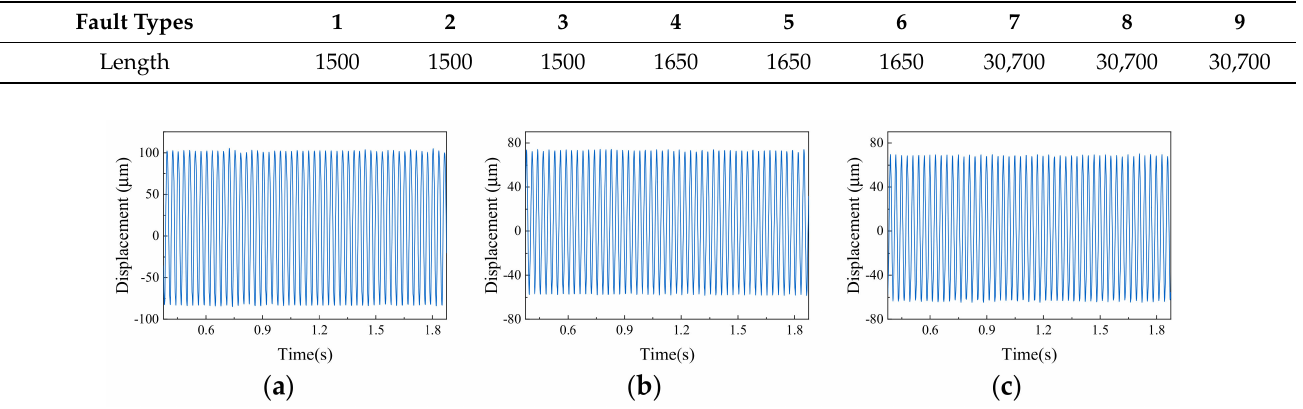
Figure 19. Imbalanced faults: ( a ) value of imbalance 2.5 × 10 − 5 kg · m; ( b ) value of imbalance